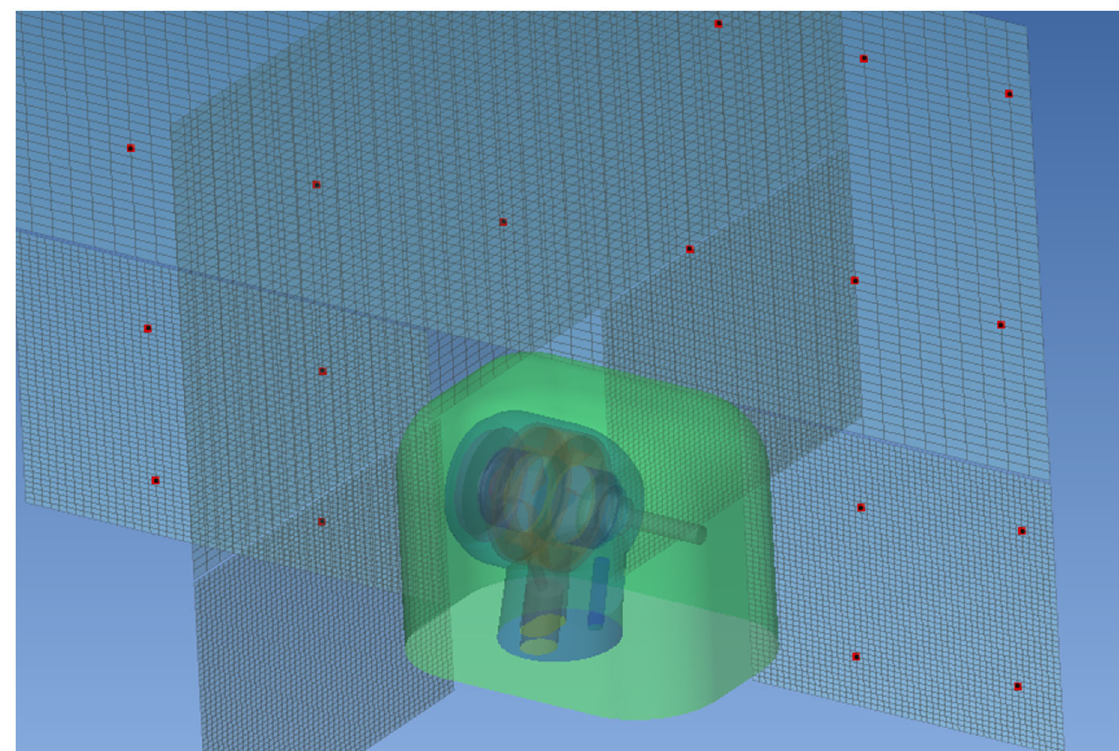
Fig. 3 Microphone array. The positions of the virtual microphones shown as red dots.